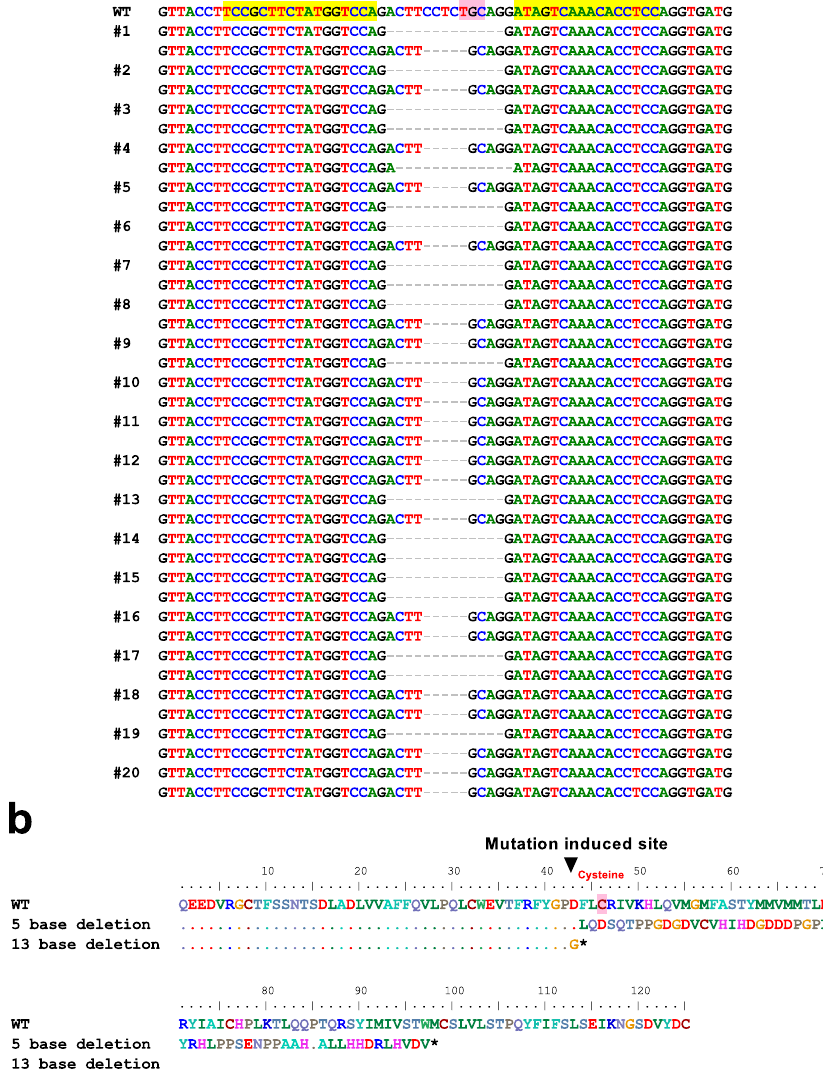
Figure 4. Establishment of the V1a2 knockout lineage. ( a ) Sequence analysis results of target gene sites in 20